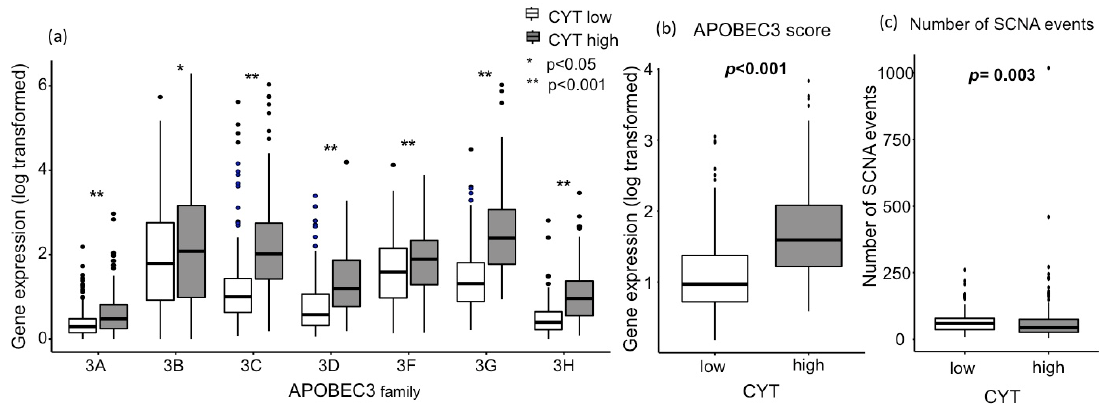
Figure 1. Association between the CYT and APOBEC3 family gene expression, as well as a number of related SCNA events. ( a ) Individual APOBEC3 family gene expression differences between CYT groups ( p < 0.05 on APOBEC3B and p < 0.001 on the rest of APOBEC3 family). ( b ) Combined APOBEC3 score ( p < 0.001). ( c ) The number of APOBEC3 family gene-related SCNA events ( p = 0.003). There are 185 and 186 patients in CYT-high and low groups, respectively. All comparisons were performed using the Mann-Whitney test. CYT , cytolytic activity score; APOBEC3 , apolipoprotein B mRNA editing enzyme catalytic polypeptide-like 3; and SCNA , somatic copy number alterations.